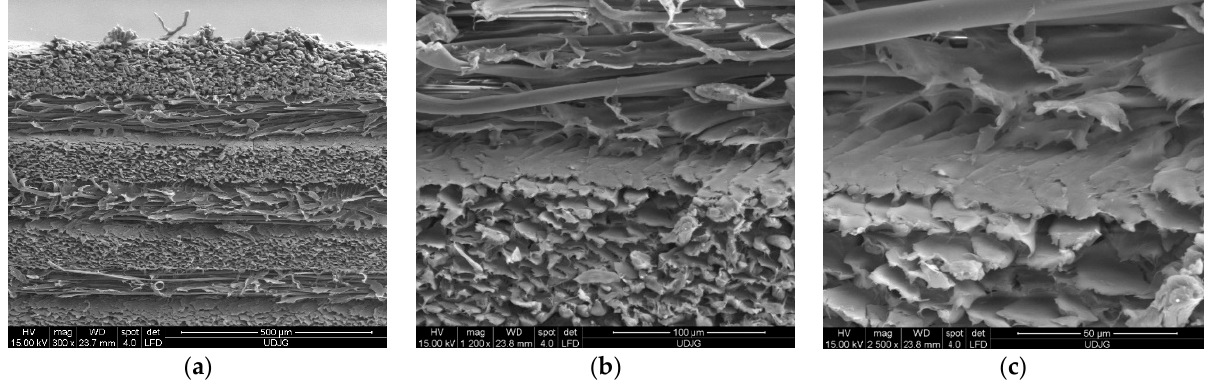
Figure 1. SEM images of the LFT SB1plus layers after being cut by the help of a power guillotine. ( a ) Magnification ×300; ( b ) magnification ×1200; ( c ) magnification ×2500.